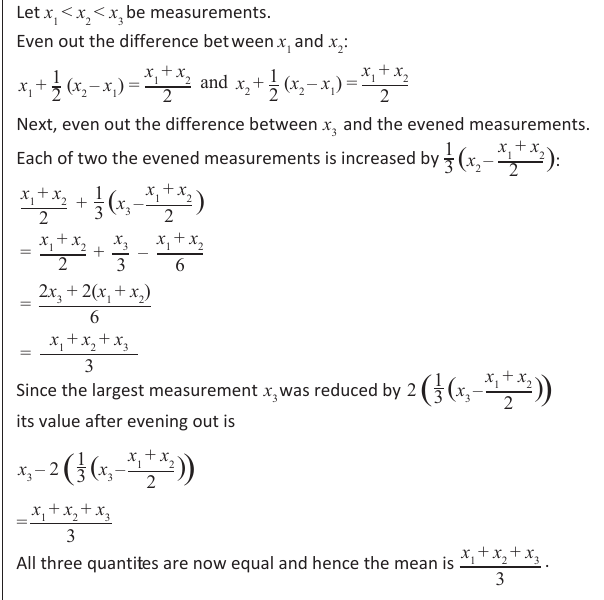
FIGURE 4: Evening out differences between ordered measurements.